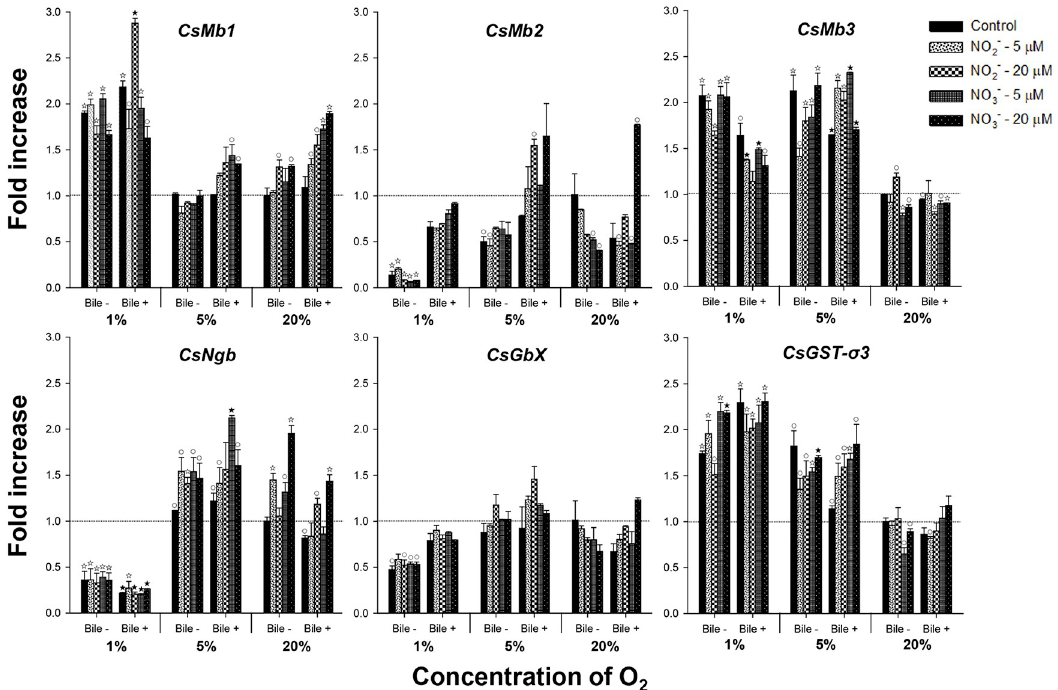
Fig 4. Expression profiles of globin genes in Clonorchis sinensis adults incubated under various experimental conditions. Live C . sinensis worms were incubated in the RPMI-1640 medium supplemented with bile, nitrite, or nitrate under 1%, 5%, or 20% oxygen conditions. After 24 h incubations, mRNA extracted from the worms was used in qRT-PCR with primer sets specific to each of the C . sinensis globin genes. Fold increases in the globin gene expression in each of the experimental groups were calculated against the 20% oxygen group without any chemical supplement (n = 2, mean ± SD). � P < 0.05; $ P < 0.01; $ P < 0.001.